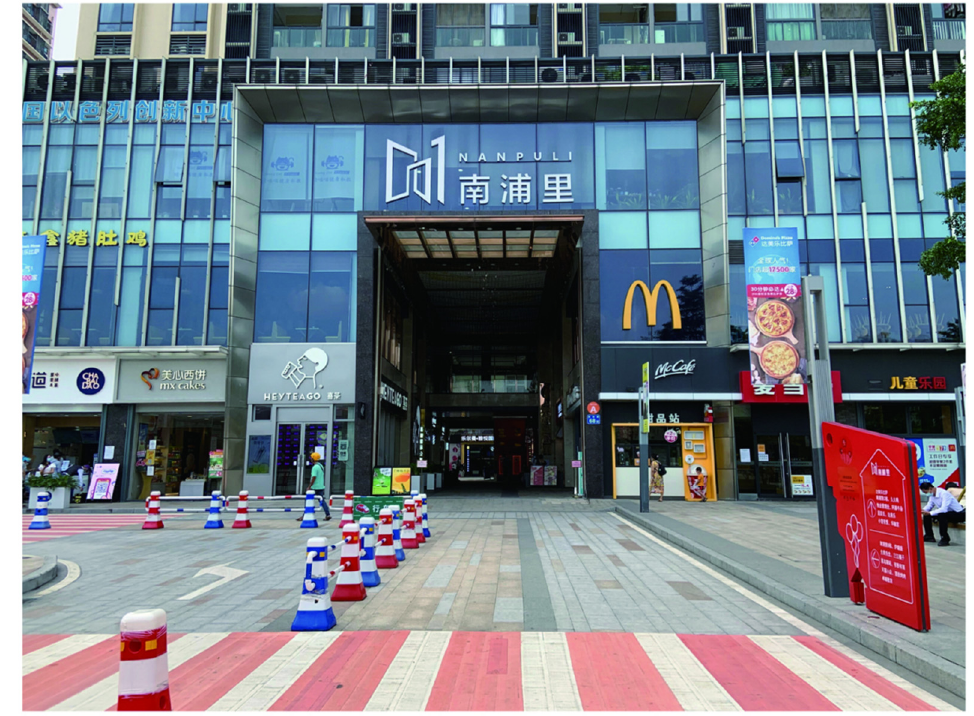
Figure 16. Current situation of the entrances and exits of Nanpu Times.